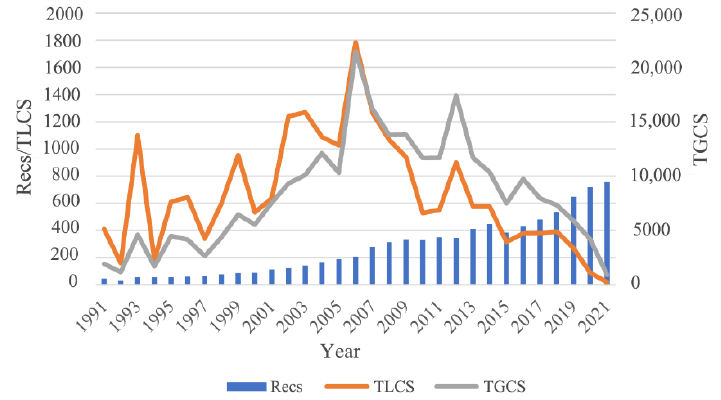
Figure 2. Yearly counts of publications (Recs), total local citation scores (TLCS), and total global citation scores (TGCS) from 1991 to 2021. The left axis: counts of Recs and TLCS. The right axis: TGCS.